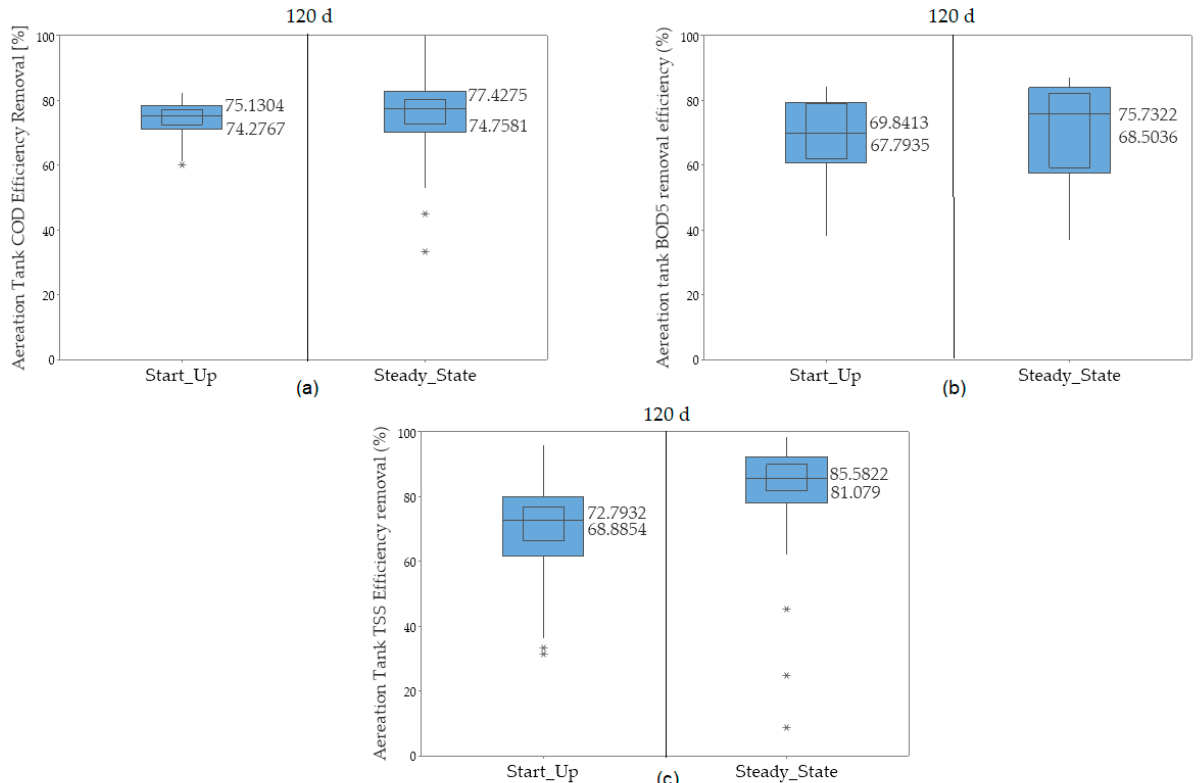
Figure 3. Aeration tank removal efficiency during start-up and steady-state operation: ( a ) COD, ( b ) BOD, and ( c ) TSS. ∗ : boxplot outliers